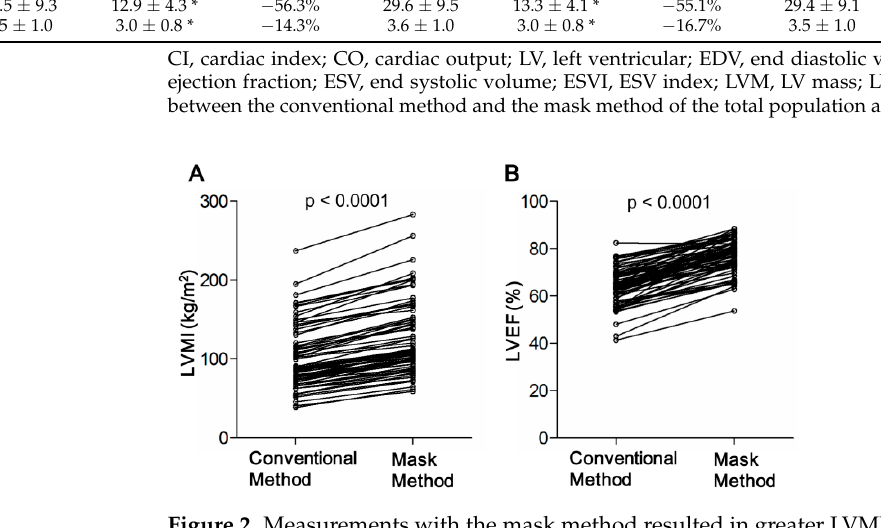
Figure 2. Measurements with the mask method resulted in greater LVMI ( A ) and LVEF ( B ). Table 2. CMRI findings according to two methods of analysis in patients with hypertrophic ob- structive cardiomyopathy.